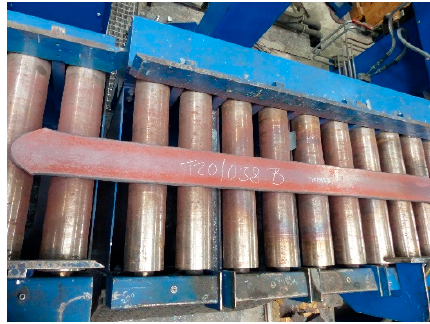
Figure 7. Hot rolled plate. Heat B.